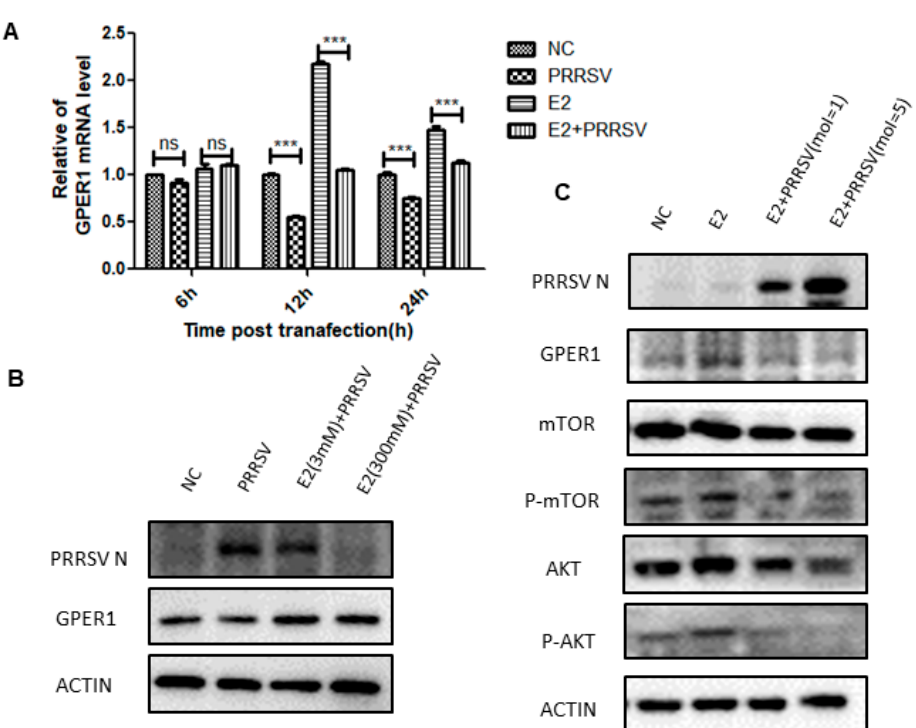
Figure 5. Effects of PRRSV-infected PTR2 cells (MOI = 1) on the transcription of GPER1 genes under estrogen (E2)-stimulated and unstimulated conditions ( A ). Effects of PRRSV infection on PTR2 cells (MOI = 1) on GPER1 protein expression, and the effects of different concentrations of estrogen on PRRSV replication ( B ). Effects of PRRSV in different doses infecting PTR2 cells on the estrogen-induced activation of the PI3K-AKT-mTOR signaling pathway ( C ). *** p < 0.001.